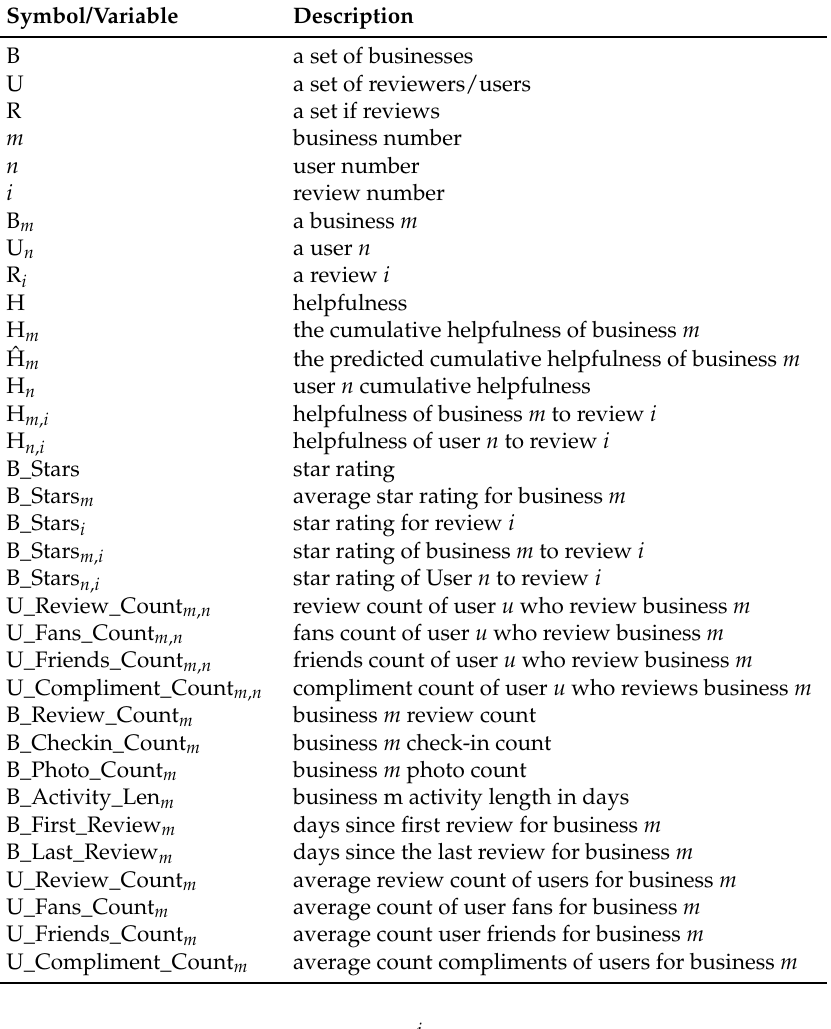
Table 2. Description of symbols and